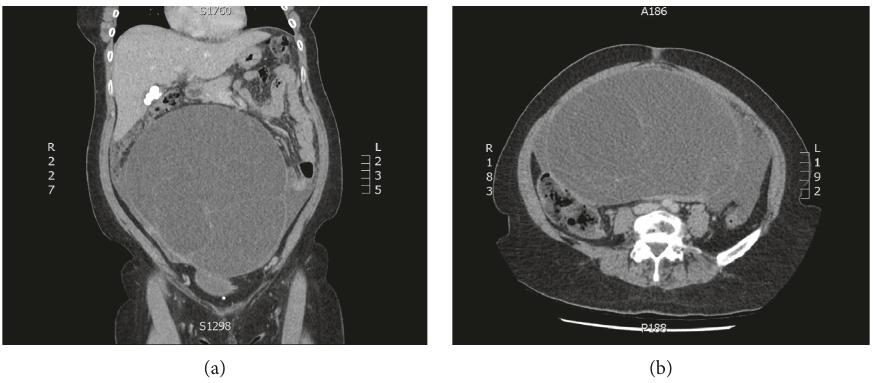
Figure 2: (a, b) Follow-up CT showing ruptured ovarian